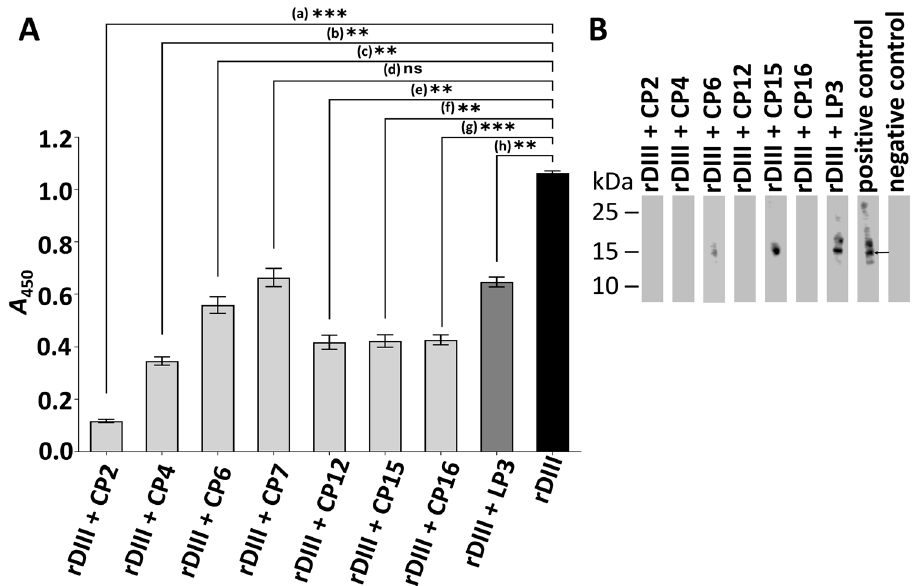
Figure 4. Assessment of the blocking ability of peptides on proteins of hBMECs. ( A ) Blocking of the interaction between proteins of hBMECs and rDIII by ELISA. Proteins of hBMECs were coated into microtiter wells. Data present mean of triplicates with ± S.D after subtraction of negative control (rDIII excluded from the assay). A statistically significant difference (P < 0.01, two-tailed P-value, GraphPad Prism v8.4.3.) was calculated by paired t-test compared to the positive control (interaction between rDIII and hBMECs proteins). a: P = 0.0002; b: P = 0.0010; c: P = 0.0058; d: P = 0.0101 (ns); e: P = 0.0015; f: P = 0.0017; g: P = 0.0004; h: P = 0.0021. A – Absorbance. ( B ) Blocking of the interaction between proteins of hBMECs and rDIII by Western blot. Arrow shows interaction between rDIII and ~ 15 kDa receptor of hBMECs. Positive control – unblocked rDIII incubated hBMECs proteins. Negative control – rDIII was omitted from the protocol. rDIII – recombinant DIII; CP – 7-mer cyclic peptide; LP – 12-mer linear